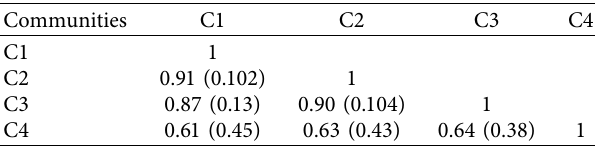
Table 8: Pairwise comparison of Sorensen’s similarity coefcient and beta diversity among four plant